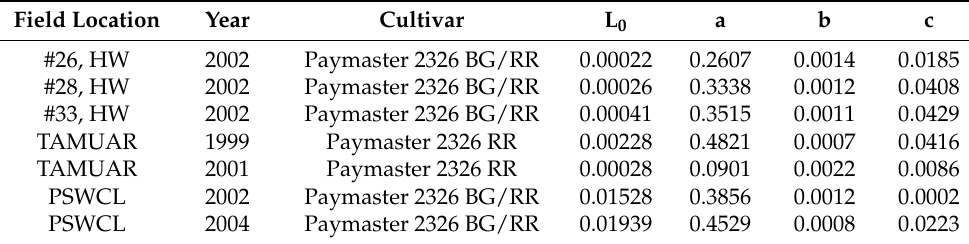
Table A2. Initial leaf area index (L 0 ), leaf partitioning and senescence (a, b, and c) parameters com- bined after the mid-season calibration of the remote sensing-integrated cotton model. Measurements were taken in fields #26, #28, and #33 in Halfway (HW), Texas; the Texas A&M University Agricultural Research (TAMUAR) farm near Lamesa; and the Plant Stress and Water Conservation